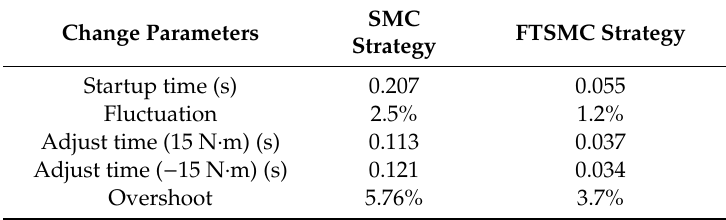
Figure 8. Observation values of torque. ( a ) FTSMC, ( b ) SMC.